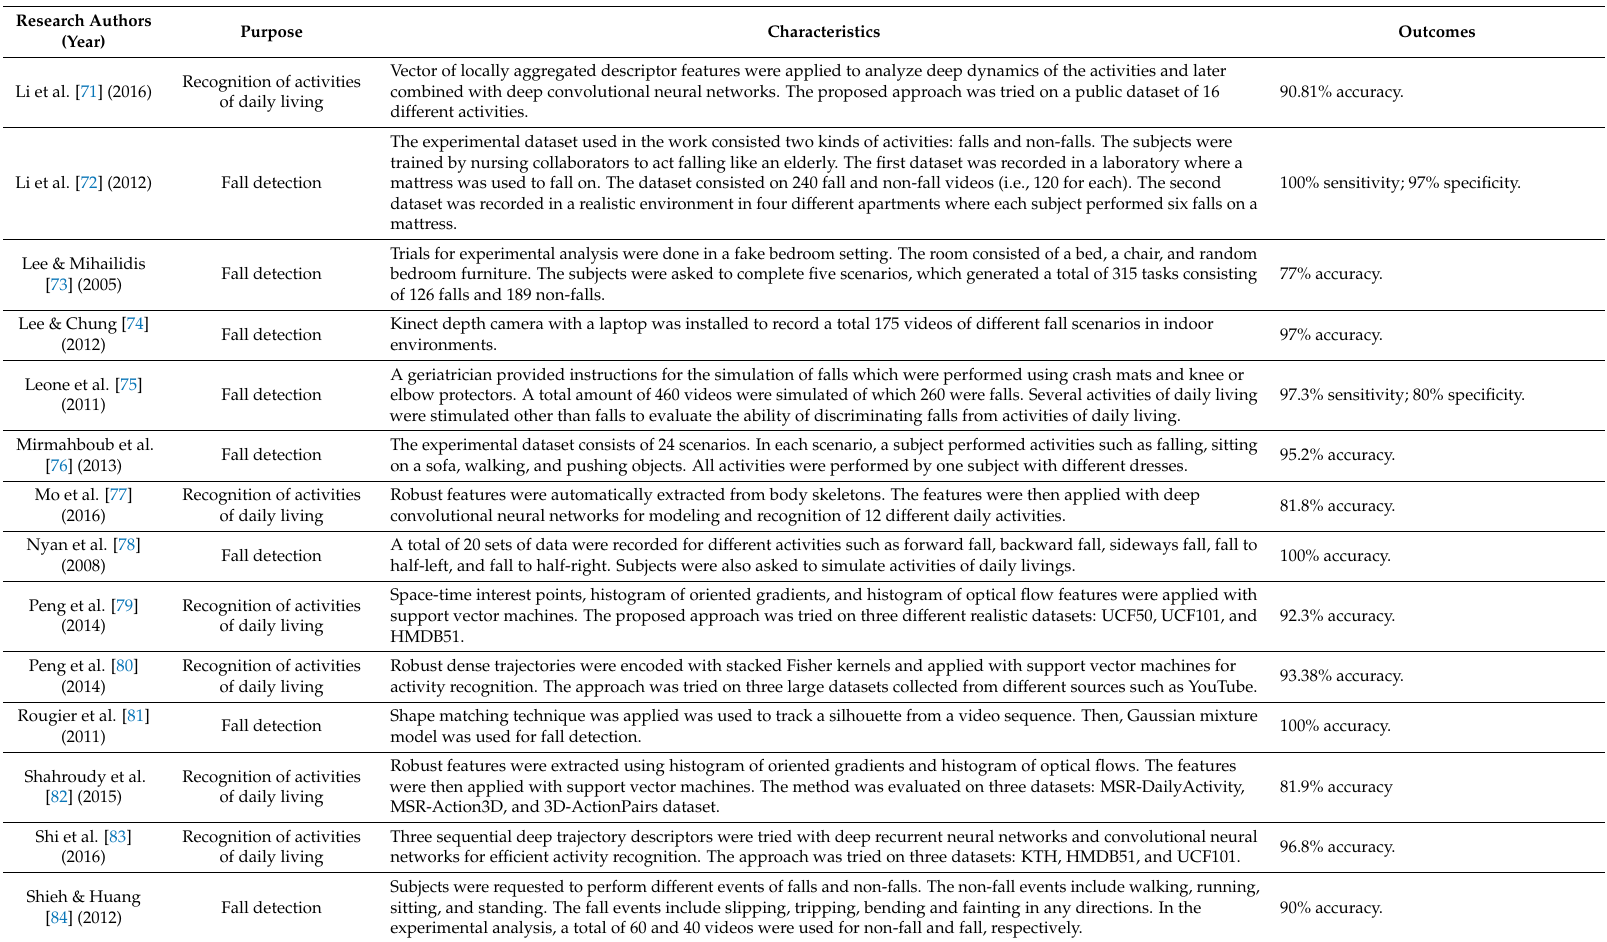
Table 3. Summary of research works that use video sensor